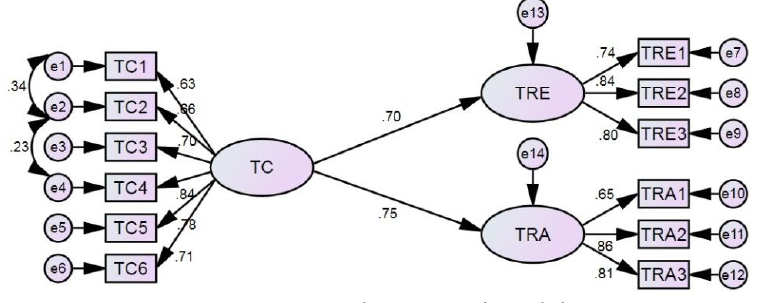
Fig. 2. Research structural